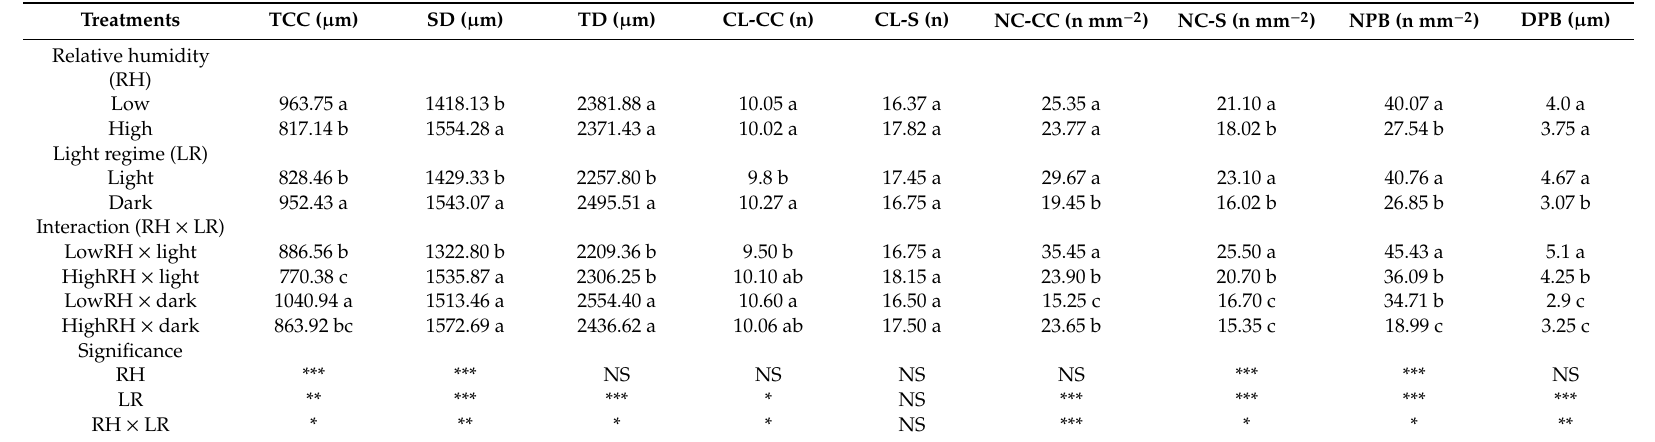
Table 2. Analysis of variance and means comparison for the thickness of cortycal cylinder (TCC), stele diameter (SD), total diameter (TD), number of cell layers in the cortical cylinder (CL-CC) and in the stele (CL-S), number of cells per unit area in the cortical cylinder (NC-CC), and stele (NC-S), number of phenolic bodies (NPB), Diameter of phenolic bodies (DPB) in mung bean sprouts under low and high RH and light or dark LR as well as under the four di ff erent combinations of RH and LR (LowRH-l; LowRH-D; HighRH-L; HighRH-D). Mean values and statistical significance are shown. NS, *; **, *** Non significant or significant at p ≤ 0.05, 0.01, and 0.001, respectively. Di ff erent letters within each column indicate significant di ff erences, according to Duncan’s multiple-range test ( p = 0.05).